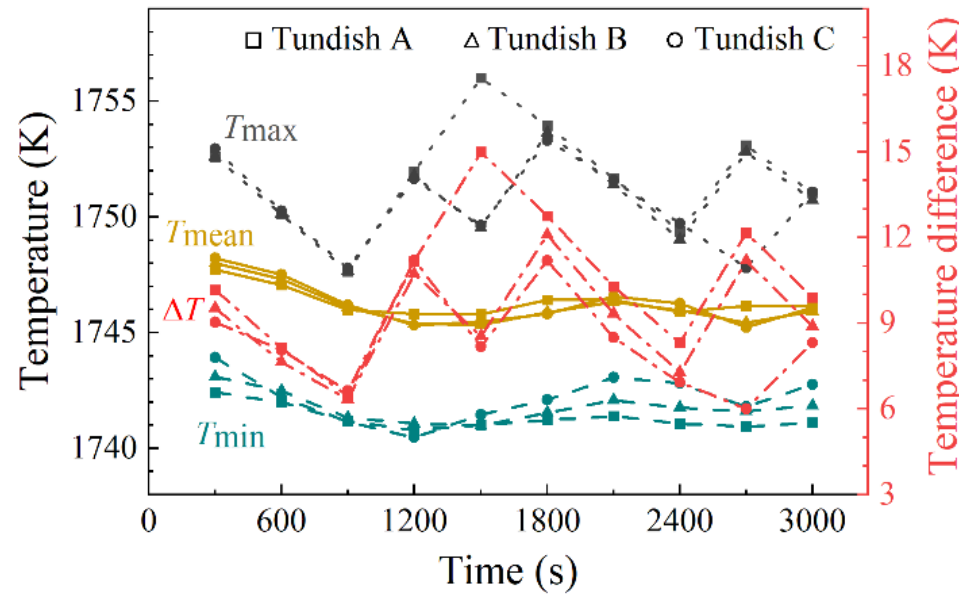
Figure 15. Statistics on temperature of molten steel in distributing chamber when tapping temperature gradually drops. Square represents tundish A, triangle represents tundish B, and circle represents tundish C. Gray dot line represents maximum temperature; yellow solid line represents average temperature; cyan dash line represents the minimum temperature; red dot dash line represents temperature difference between maximum and minimum temperature.